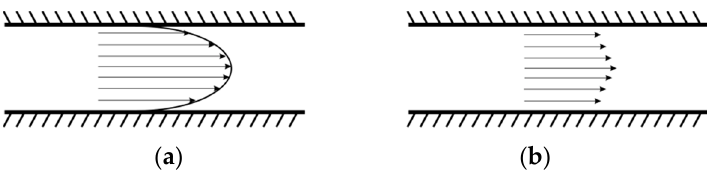
Figure 4. Schematic diagram of gas slippage effect: ( a ) Liquid flow through a capillary; ( b ) Gas flow through a capillary [2].